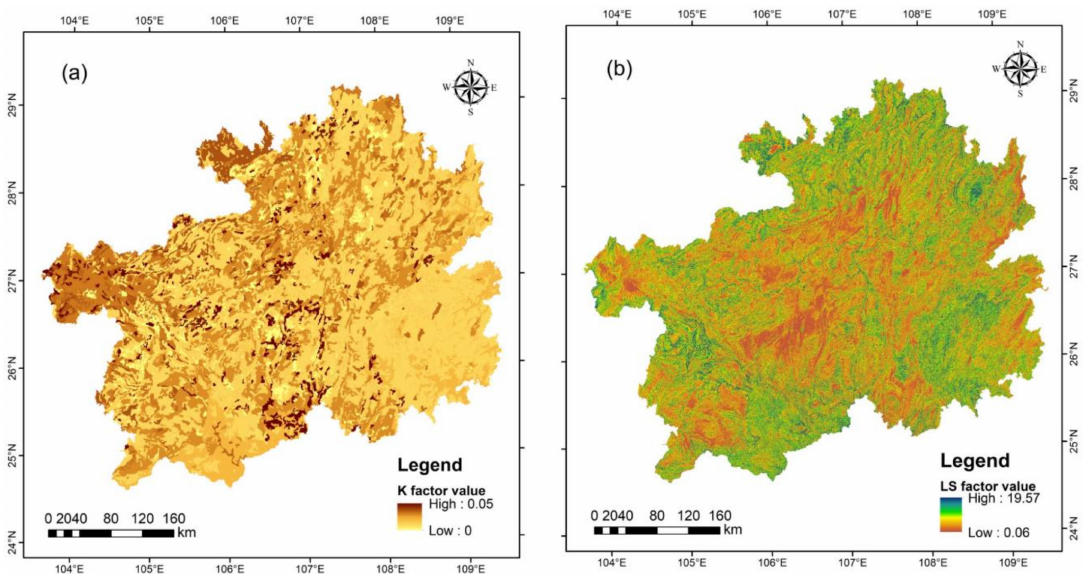
Figure 5. Spatial distribution of K ( a ) and LS ( b ) factors on the Guizhou Plateau.